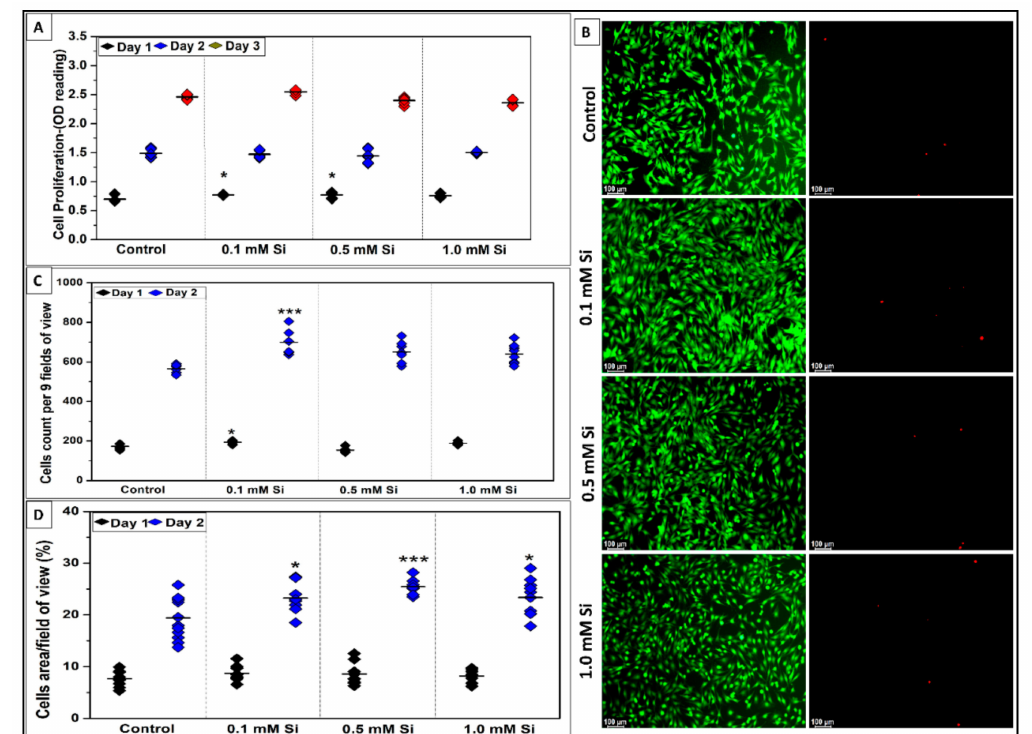
Figure 2. Effect of Si-ions concentration on C2C12 cells proliferation for 3 days. ( A ) Data distribution graph shows the MTS-assay results of C2C12 cell proliferation with 3 different concentration of silicon ions for 1, 2, and 3 days. 0.1 mM Si significantly increased the number of cells at day 1 and 3, (* p < 0.05). ( B ) Fluorescent pictures (10 × view) of C2C12 cells stained with live/dead assay kit shows the live (green) and dead (red) cells after 2 days of proliferation. Almost no dead cells were observed for the control and silicon ions groups. ( C ) Data distribution graph presents the number of cells per 9 fields of view counted from the fluorescent pictures. The cell counts confirmed that 0.1, 0.5, and 1.0 mM Si-ions significantly increased the total number of cells by day 2 of proliferation. ( D ) Cell area percentage confirmed that Si-ions significantly increased the area covered by C2C12. (—) in the graphs represents the mean and the scale bar on the pictures is 100 µ m, (*** p < 0.001, n = 3 per